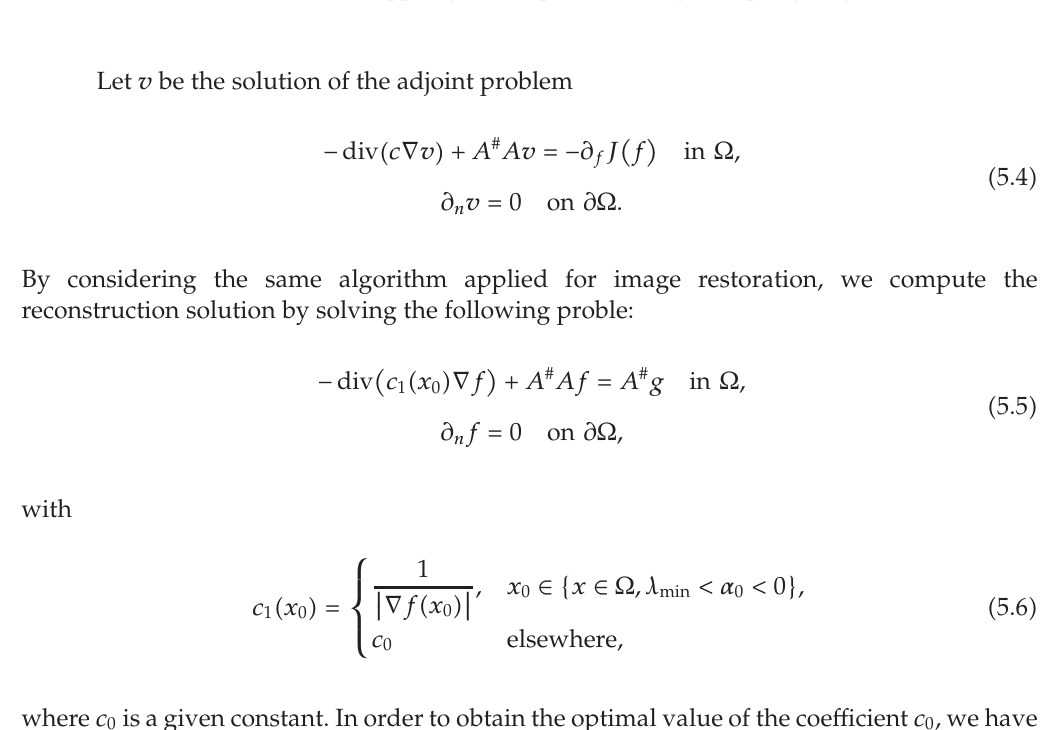
Figure 7: Reconstruction of the Shepp-Logan head phantom using the topological gradient